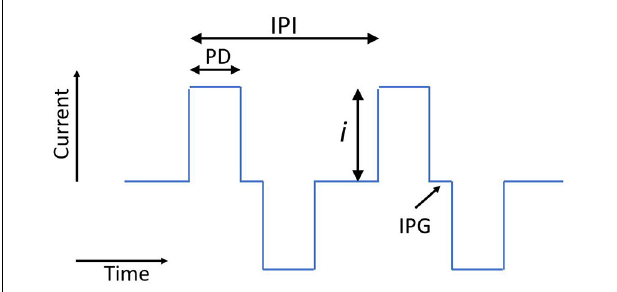
FIGURE 1 | Schematic showing two biphasic current pulses and the parameters current (i), pulse duration (PD), interphase gap (IPG), and interpulse interval